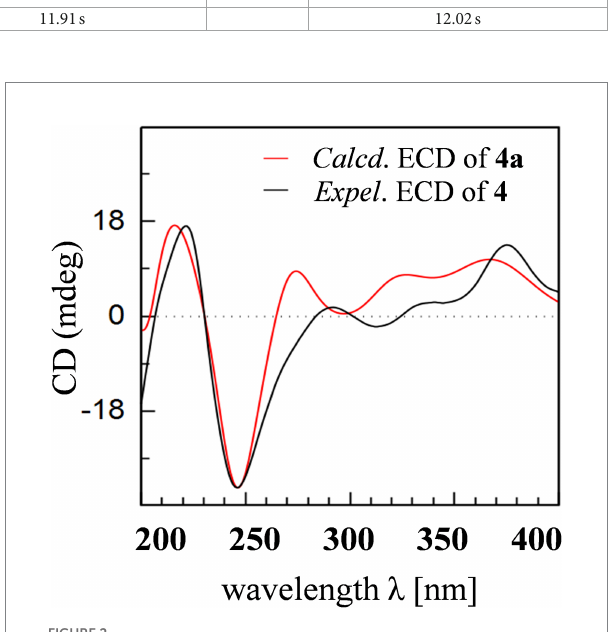
FIGURE 2 Experimental ECD spectrum of 4 and calculated ECD spectrum